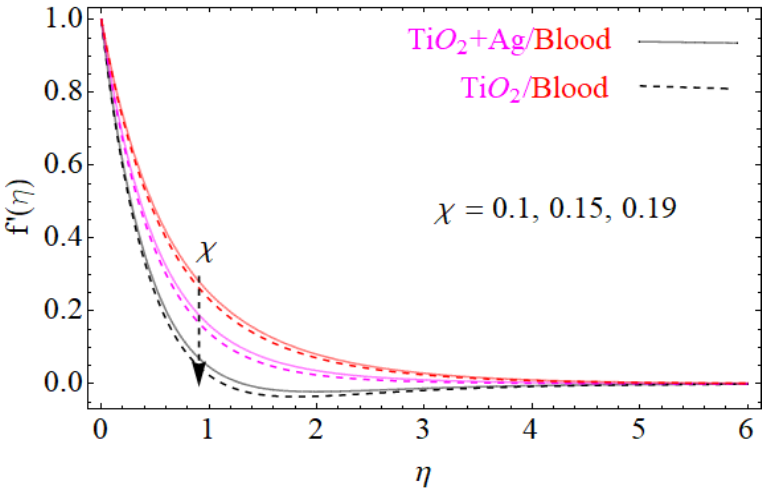
Figure 3. Effect of unsteady parameter on velocity profile.